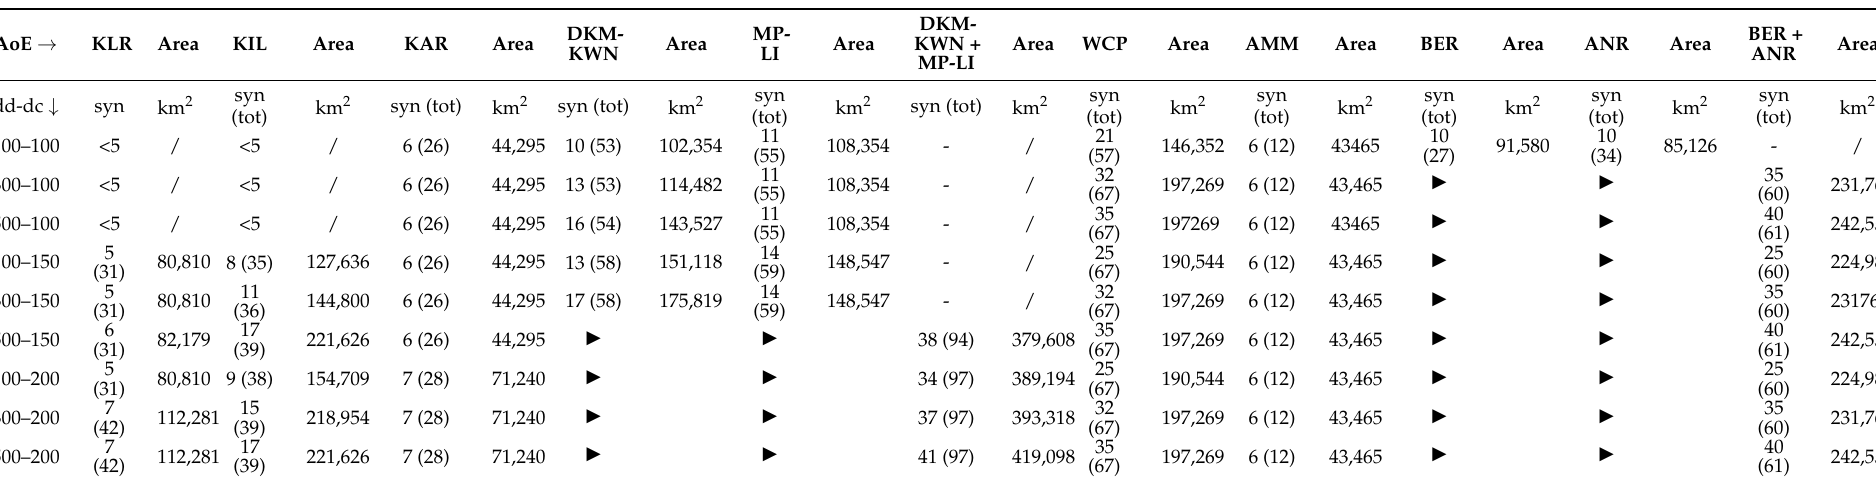
Table 1. Surface and number of sinendemisms for the AoEs identified by the DBSCAN analysis. dd = maximum diameter of the distribution of the species; dc = maximum distance between the centroids; ► indicates the merger of areas.